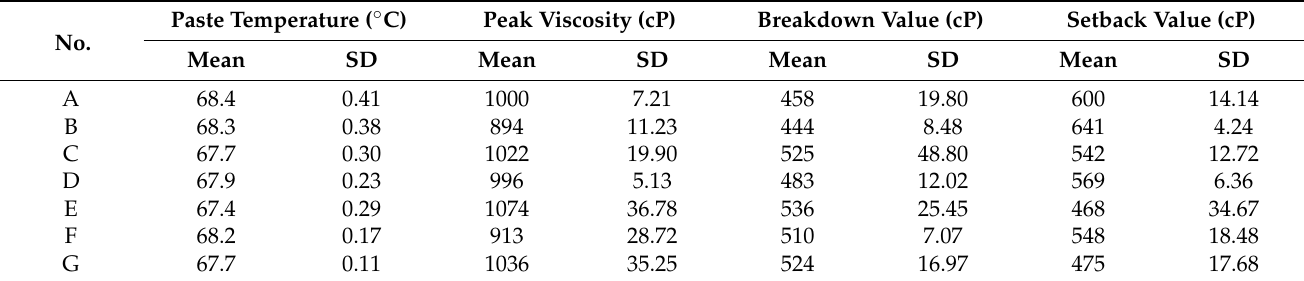
Table 3. Pasting characteristics of paddy after different drying